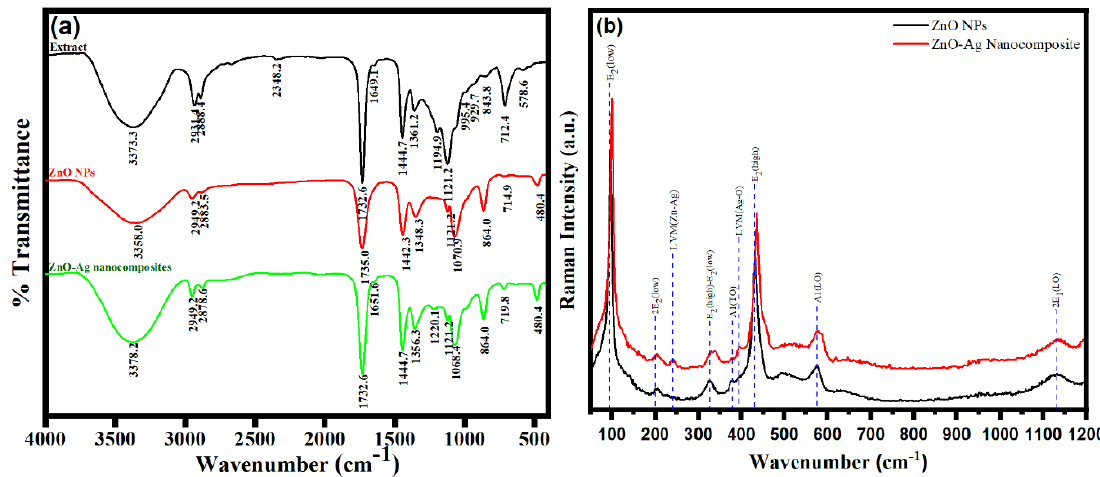
Figure 5. ( a ) FTIR spectra of Safflower, ZnO NPs, and ZnO – Ag nanocomposite, ( b ) Raman spectra of ZnO NPs and ZnO – Ag